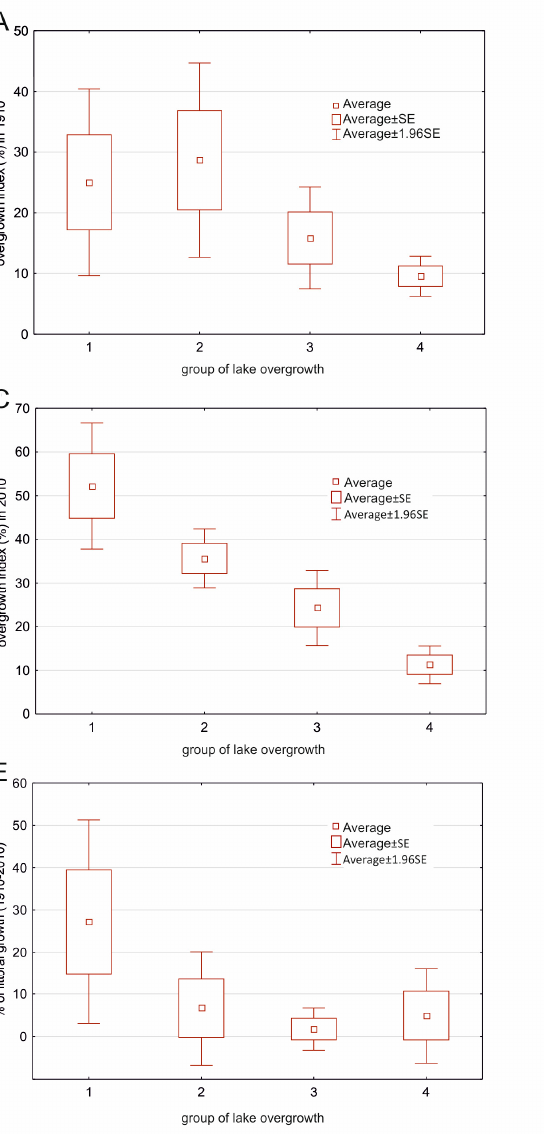
Figure 4. Share of emerged vegetation in lakes in ( A ) 1910, ( B ) 1980, ( C ) 2010 and ( D ) overgrowth rate, ( E ) percentage of littoral growth and ( F ) percentage of lake disappearance analyzed in the period 1910–2010.